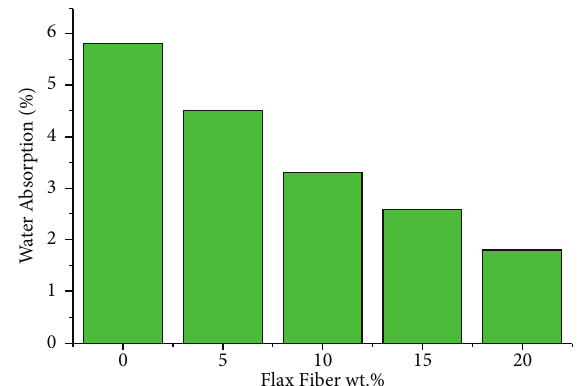
Figure 10: Water absorption of pure and hybrid composites during 48hours of immersion in